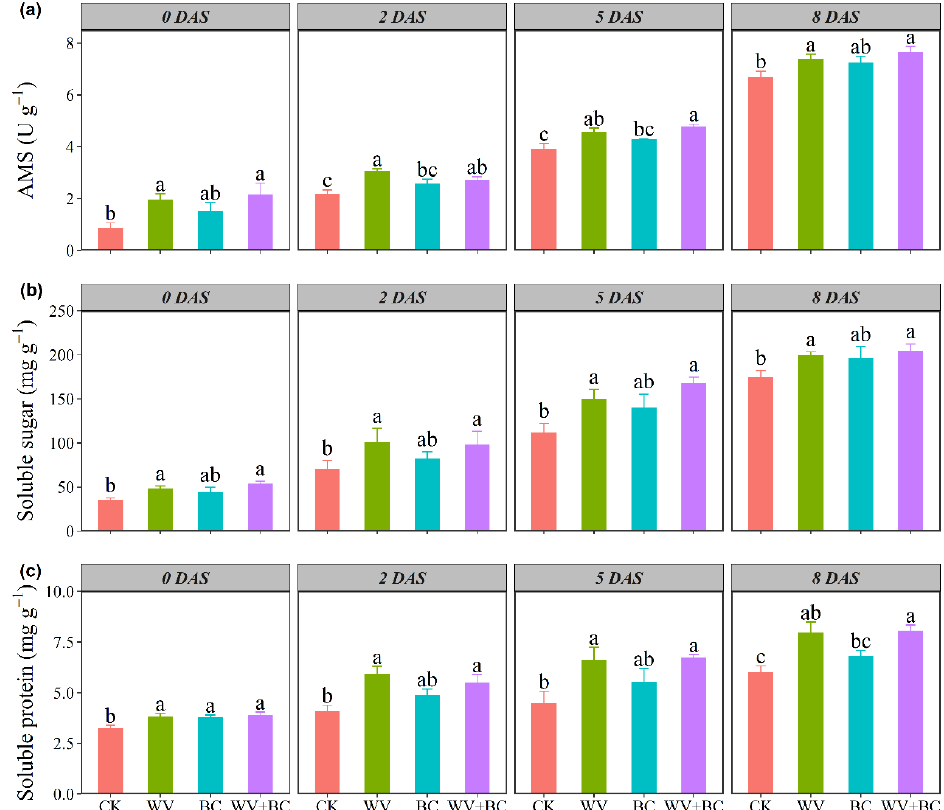
Figure 6. Dynamic changes in ( a ) AMS ( b ) soluble sugar ( c ) soluble protein of rice seeds and seedlings in different seed treatments at 0, 2, 5, 8 DAS under growth chamber experiment. Different letters show a significant difference between treatments at p = 0.05 according to LSD test. Error bars indicate standard error of three replicates. CK: untreated seeds, WV: wood vinegar seed priming, BC: biochar seed coating, WV + BC: co-treatment of wood vinegar priming and biochar coating.